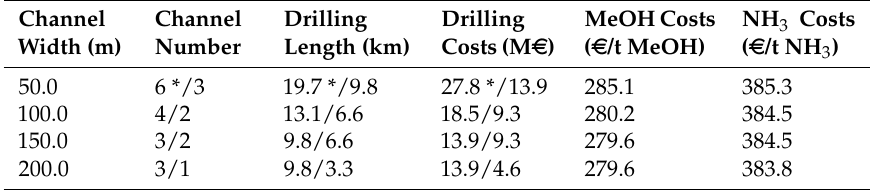
Table 22. Different channel widths and resulting levelized methanol/ammonia costs.